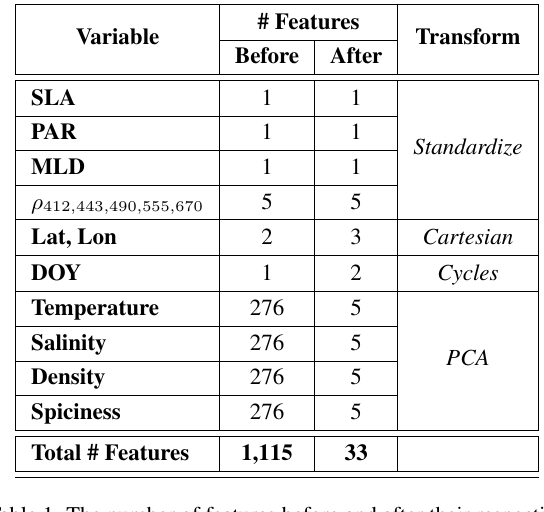
Table 1. The number of features before and after their respective transformations for different input variables used for the machine learning models.